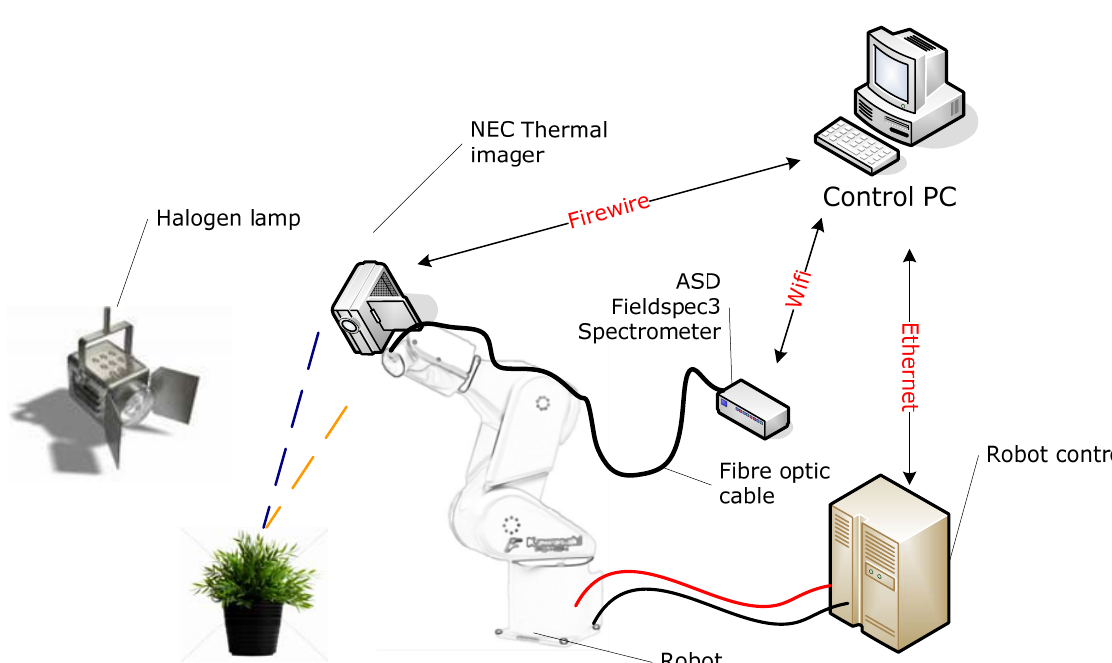
Figure 2. Topology of the goniometer